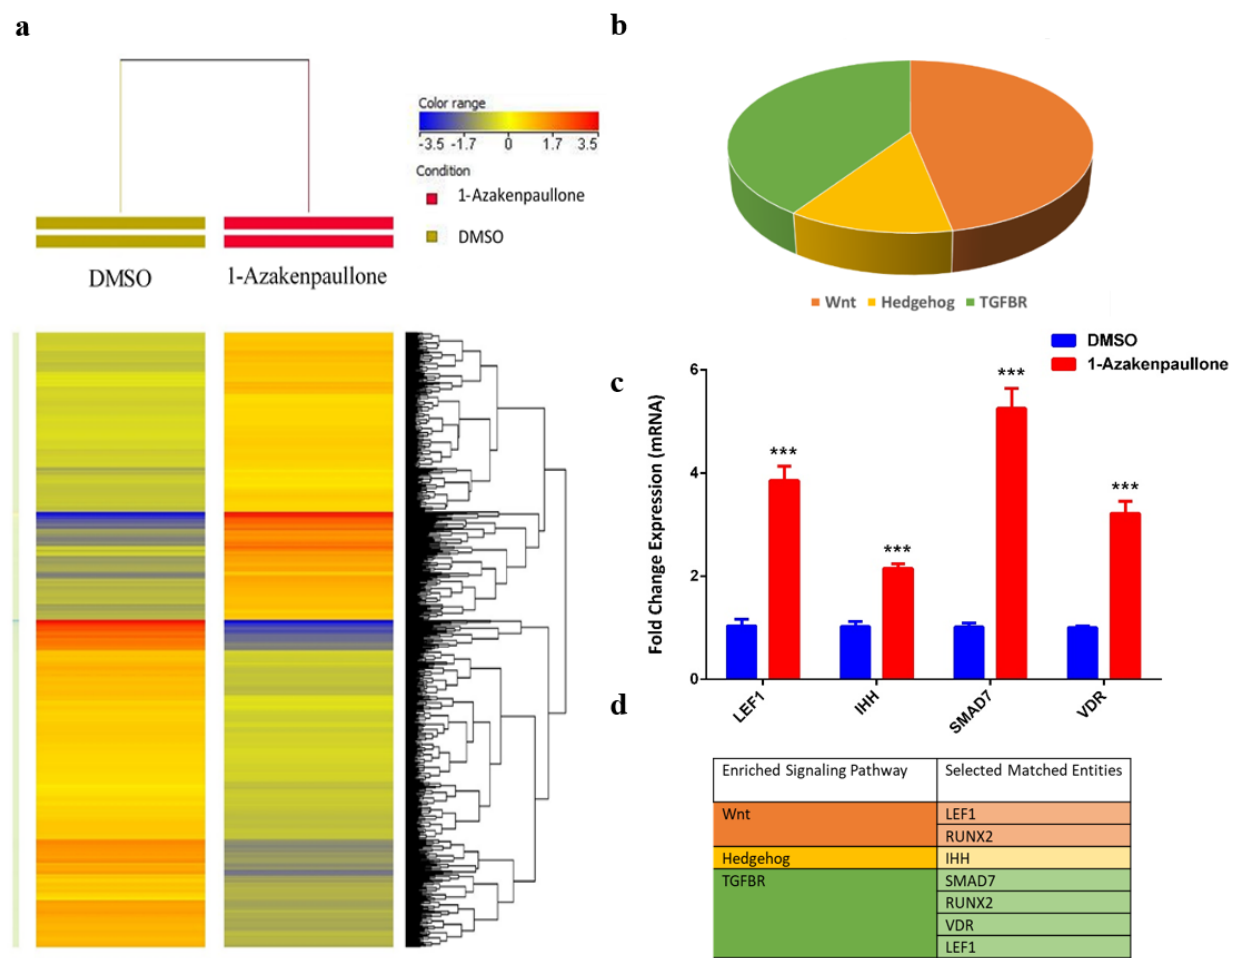
Figure 3. 1-Azakenpaullon enhances expression of multiple signaling pathways in human MSCs during osteoblastic di ff erentiation. ( a ) Heat map and unsupervised hierarchical clustering performed on differentially expressed genes during osteoblastic differentiation of 1-Azakenpaullon-treated human MSCs versus DMSO-treated control cells. ( b ) Pie chart demonstrating the distribution of selected signaling pathways enriched in the significantly upregulated genes identified in 1-Azakenpaullon-treated human MSCs versus DMSO-treated control cells. ( c ) Validation of a selected panel of upregulated genes in 1-Azakenpaullon-treated human MSCs versus DMSO-treated control using qRT-PCR. Gene expression was normalized to GAPDH. Data are presented as mean fold change ± SEM ( n = 6) from two independent experiments; *** p < 0.0001. ( d ) Selected matched entities associated with the validated signaling pathways enriched in the signi fi cantly upregulated genes identi fi ed in 1-Azakenpaullon-treated human MSCs versus DMSO-treated control cells. Gene expression was normalized to GAPDH. Data are presented as mean fold change ± SEM ( n = 6) from two independent experiments; *** p ≤ 0.0005. LEF1: lymphoid enhancer binding factor 1; IHH: In- dian hedgehog homolog; SMAD7: mothers against decapentaplegic homolog 7; VDR: vitamin D receptor; DMSO: dimethyl sulfoxide.